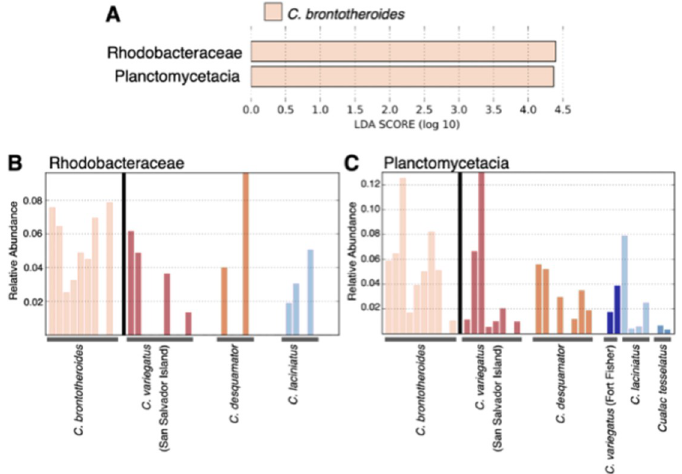
Fig 5. Linear discriminate analysis between Cyprinodon brontotheroides (molluscivore) and non-molluscivores. A) Log scores of the top two dominant loadings on the LEFSE discriminate axis separating molluscivores from all other pupfish samples. B) Relative abundance of the family Rhodobacteraceae and the class C) Planctomycetacia from all Cyprinodon gut